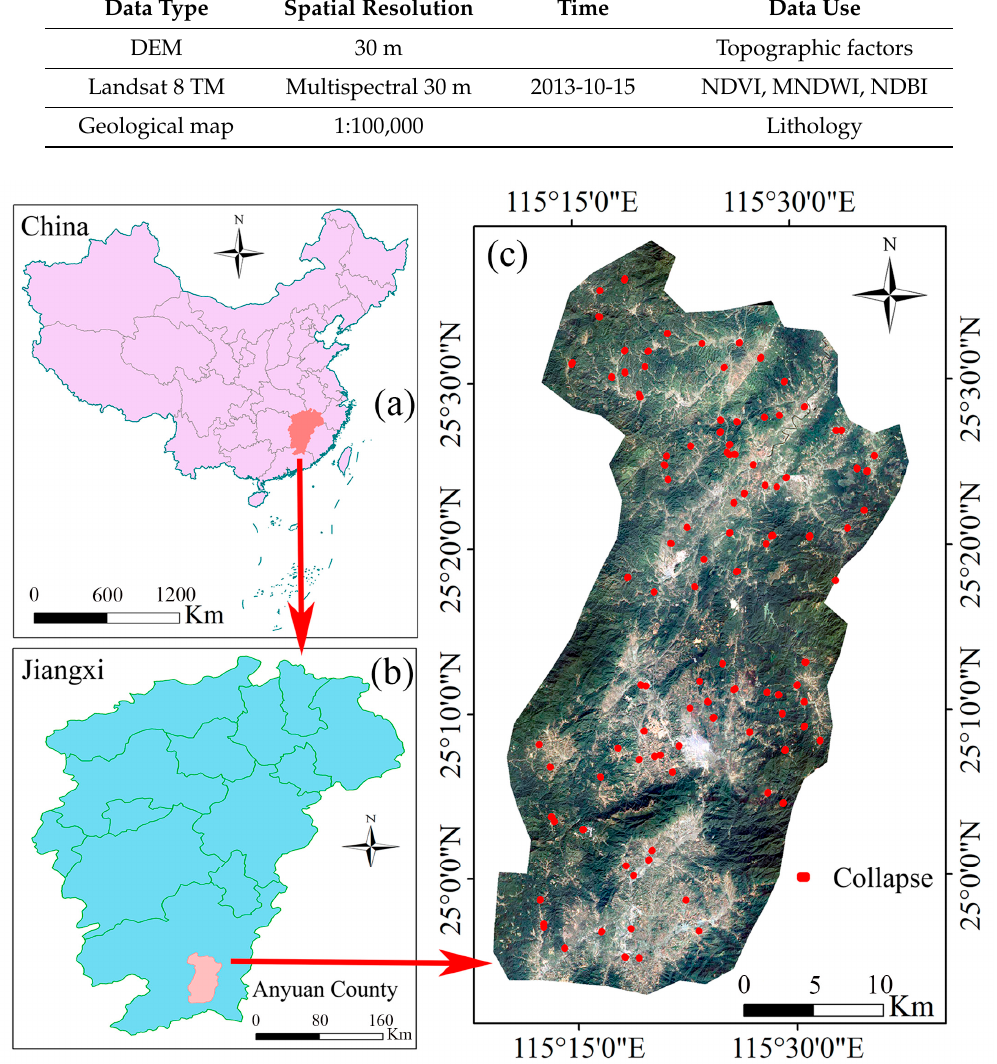
Figure 1. Geographical location of collapses: China ( a ), Jiangxi Province ( b ), An’yuan County ( c